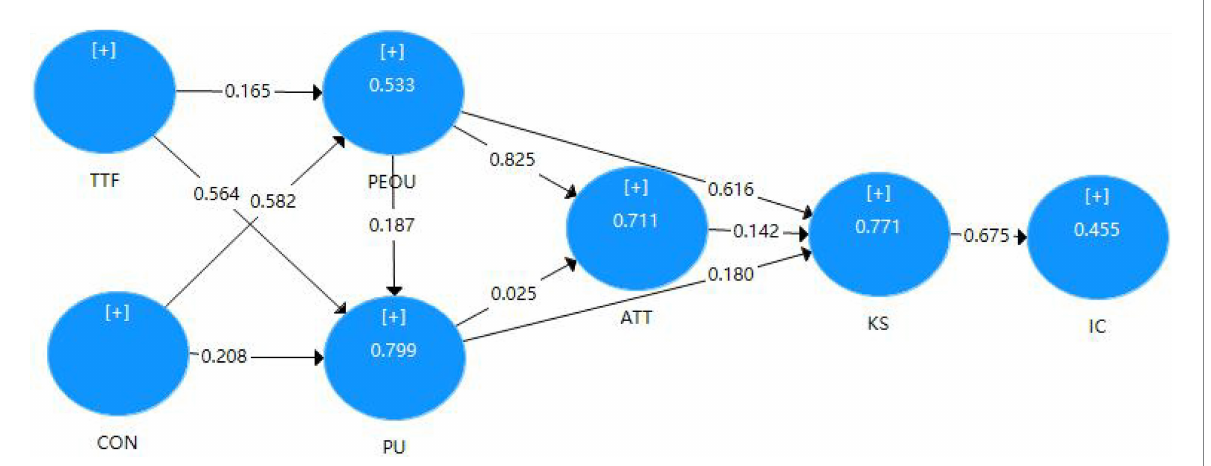
FIGURE 4 Path model result of female.